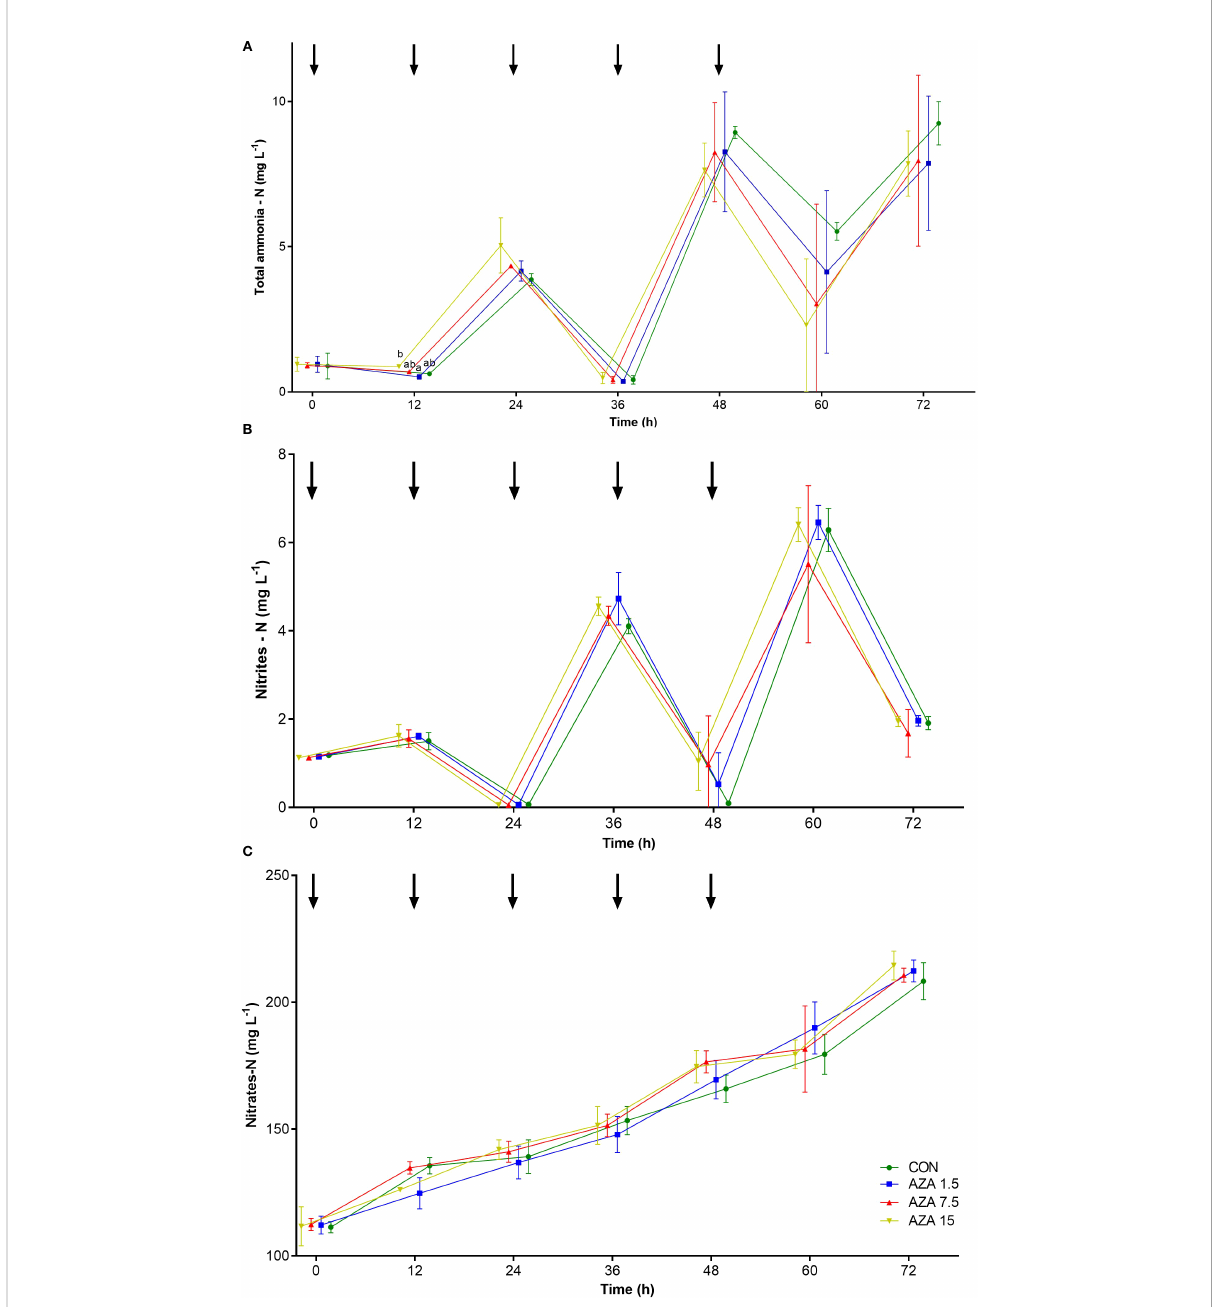
FIGURE 3 Concentrations (mean ± SD) of nitrogen compounds in the water from working bio fi lter exposed to varying concentrations of azadirachtin during 72h: (A) total ammonia – nitrogen; (B) nitrites – nitrogen; (C) nitrates – nitrogen; lines with different colors and symbols represent control group (CON), and concentration of azadirachtin insecticide (AZA 1.5; AZA 7.5 and AZA 15 µg L -1 ) added to the working bio fi lter; points are shifted to the left or to the right in order for easier comparison among groups; arrows show time when ammonium chloride was added to the buckets; different letters represent signi fi cant differences between groups within the same sampling point (one-way ANOVA followed by Tukey ˈ s HSD posthoc test,